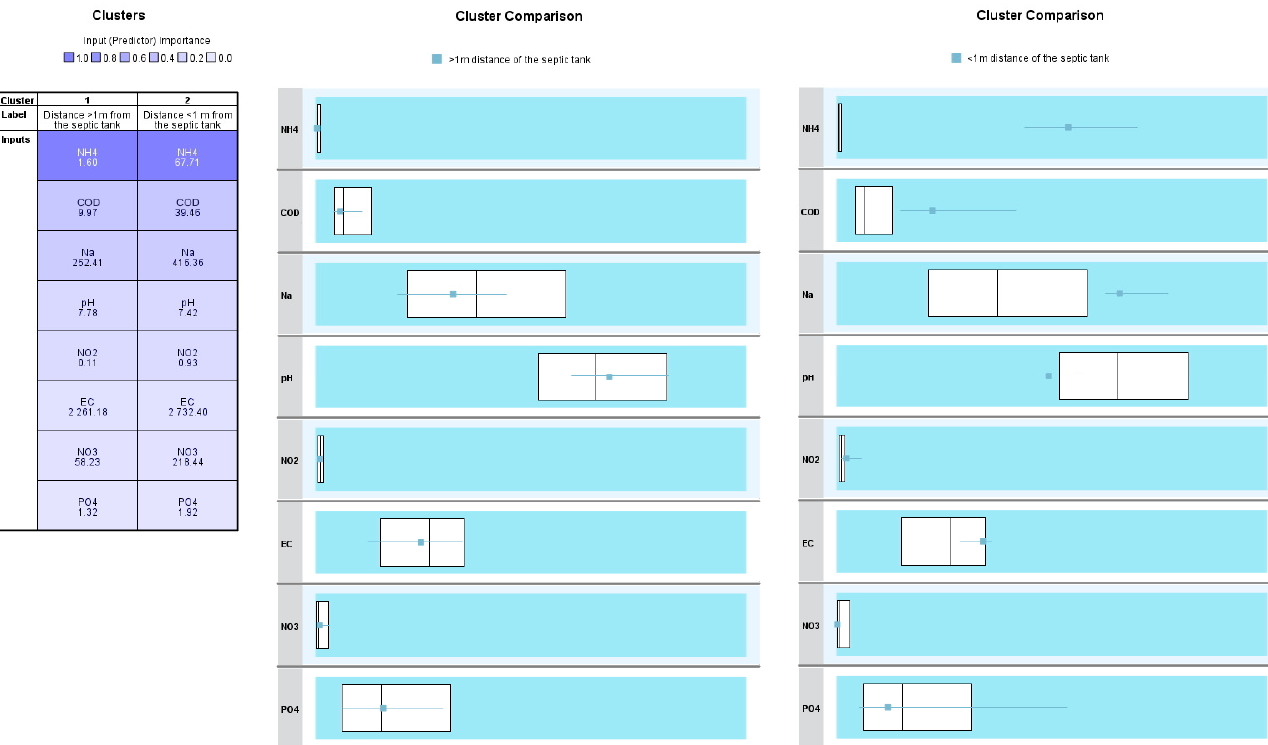
Table 2. Rotated component matrix of the